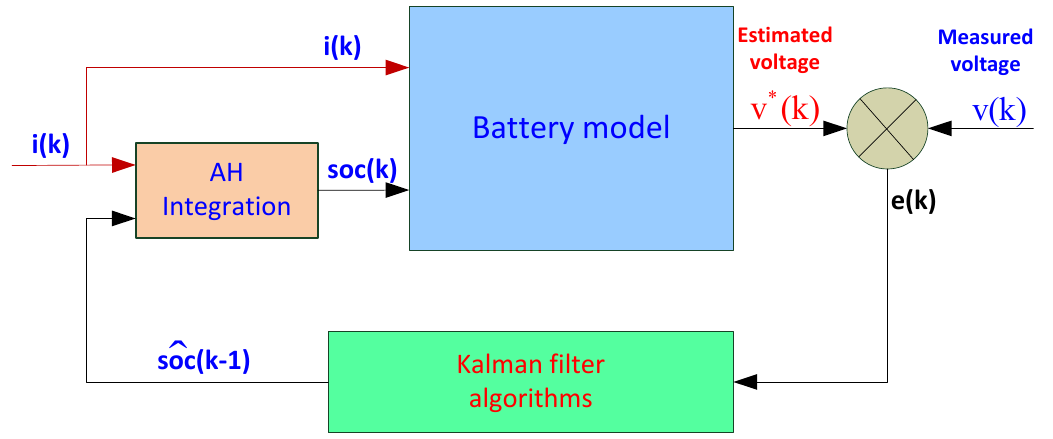
Figure 2. Closed-loop battery